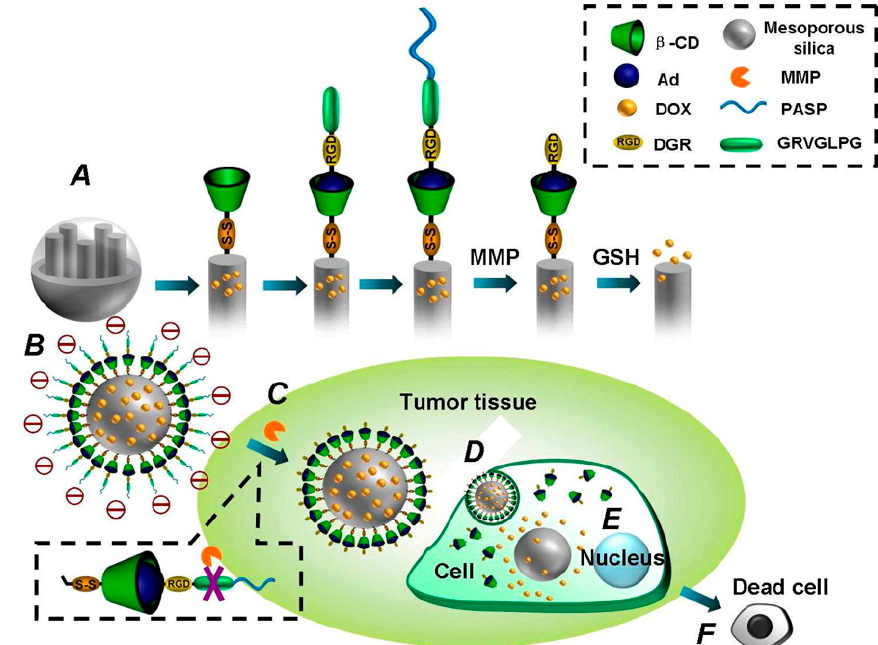
Figure 8. Structure of multifunctional envelope-type mesoporous silica nanoparticle and tumor- triggered targeting drug delivery. ( A ) Functionalization protocol of the mesoporous silica nanoparticle; ( B ) drugs loaded multifunctional envelope-type mesoporous silica nanoparticle under